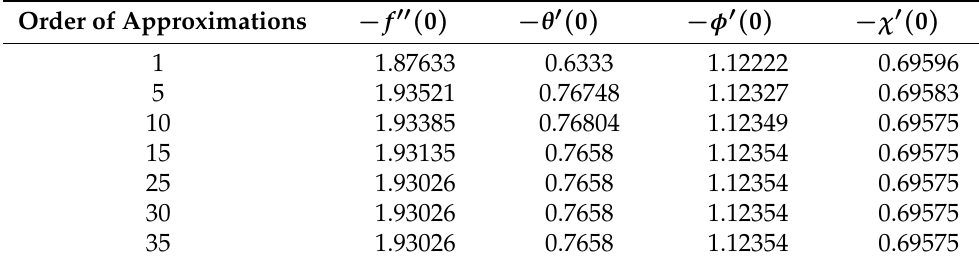
Table 1. Convergence of HAM solutions with order approximations.